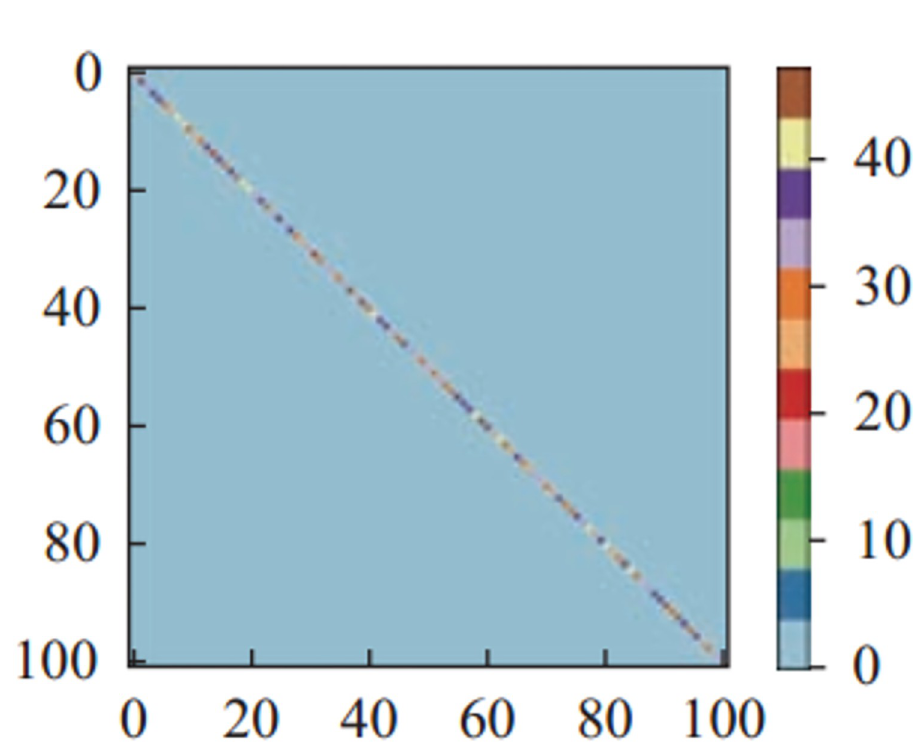
Fig 13. The confusion matrix of the first sectionalization in UCF-101 under the input cropped image.